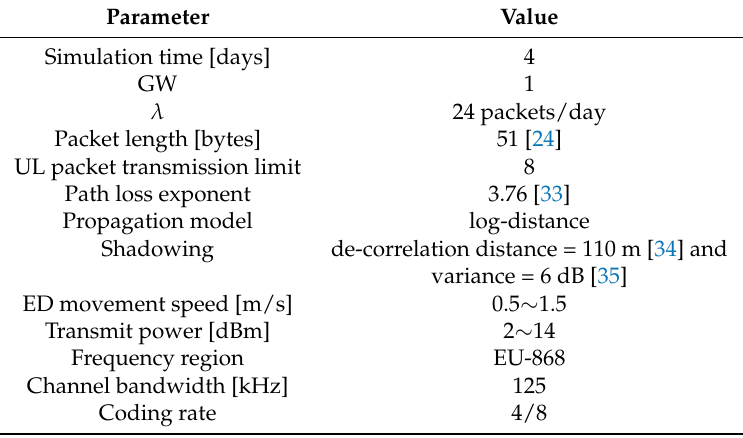
Table 2. Simulation